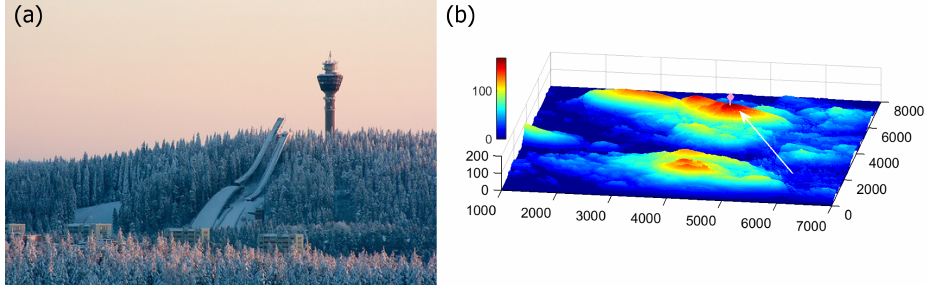
Figure 1. Photograph of tower (a) and map of topography (b)